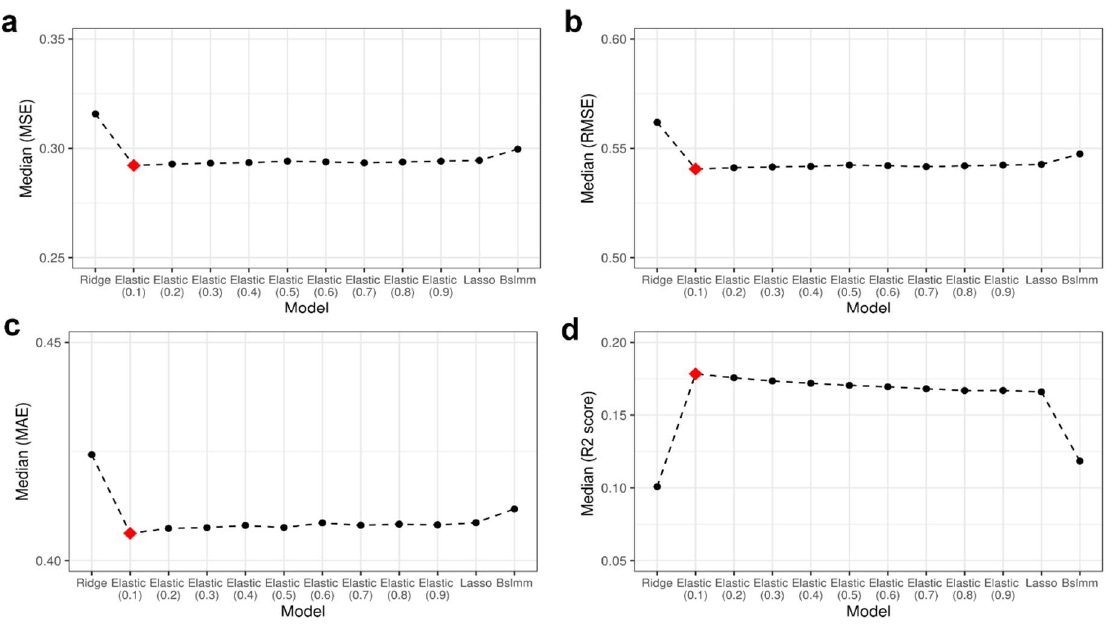
Figure 1. Performance of the candidate models. The numbers in parentheses are the α values of ElasticNet. ( a ) Median MSE for target genes per model; ( b ) median RMSE for target genes per model; ( c ) median MAE for target genes per model; ( d ) median R2 score for target genes per model. The best model is marked with a red diamond in each metric.